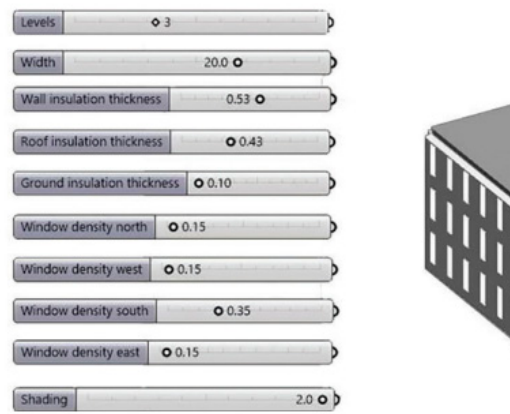
Figure 6. The optimal building shape with presented parameter values. This variant had the lowest Total Carbon Footprint as predicted by the ML (Machine Learning) model: 626,368 kg CO2eq. The actual simulated value: 634,777 kg, which means an error of 1.3% for the Machine Learning Prediction.